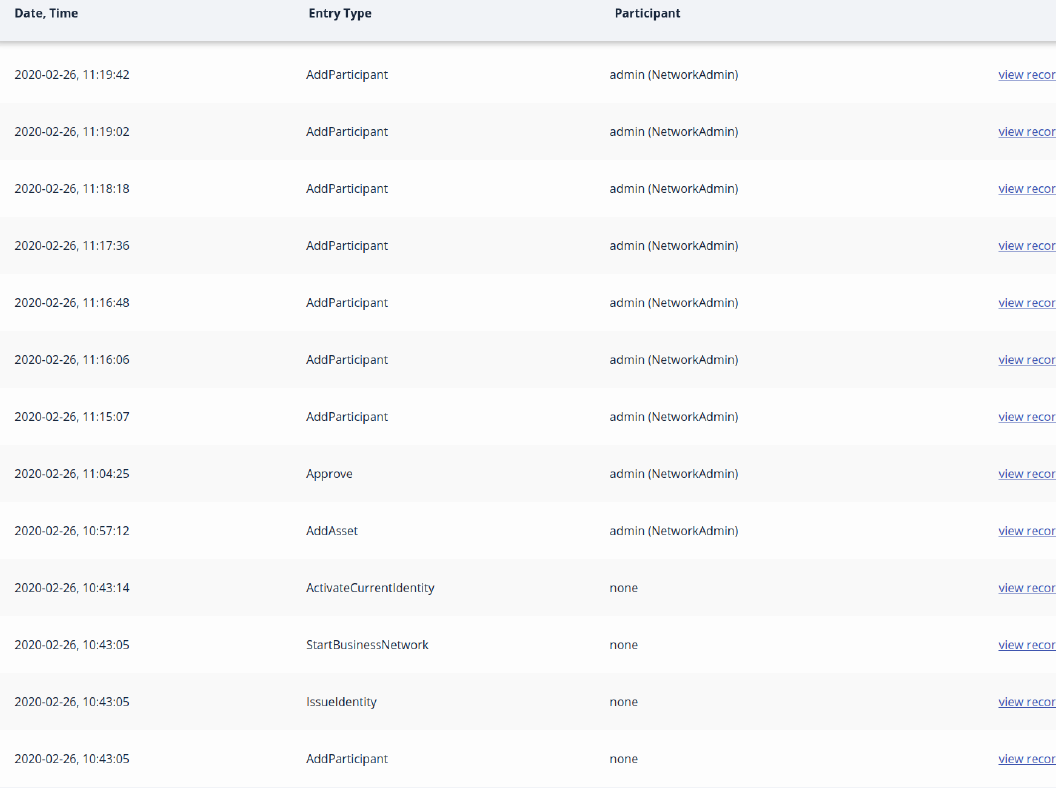
Figure 12. Transaction